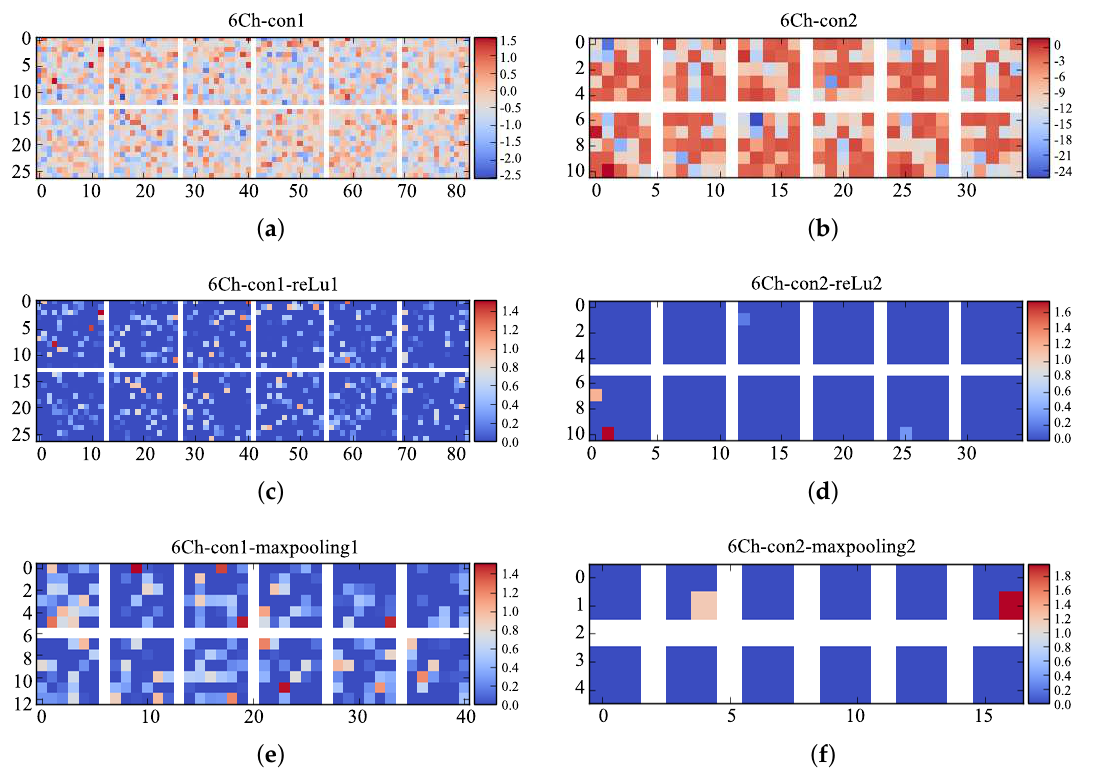
Figure 13. Visualized feature maps of the 6Ch-input. ( a , c , e ) denote the visualized feature maps of the convolution operation, ReLu operation and max-pooling operation in the first round of feature extraction; and ( b , d , f ) denote the visualization of the second round of feature